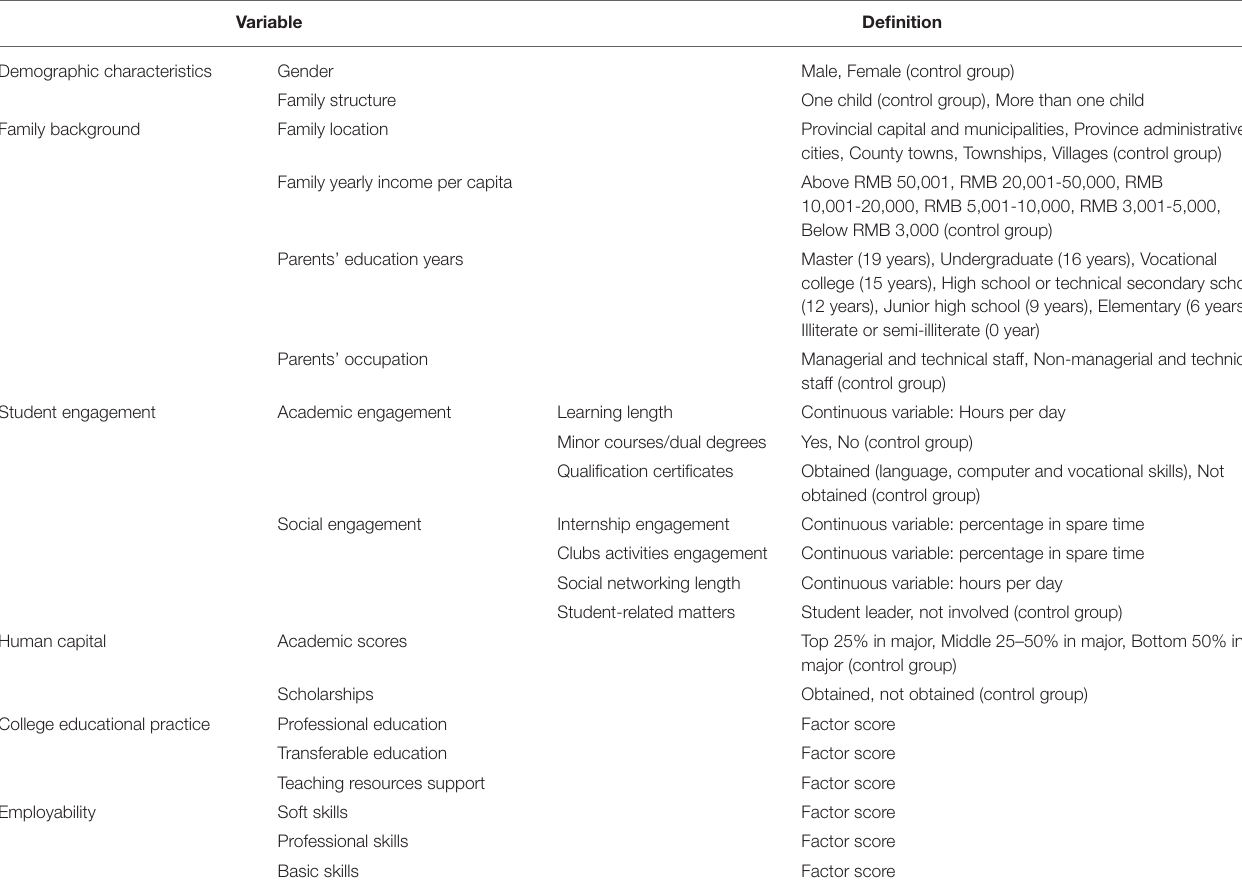
TABLE 2 | Research variables